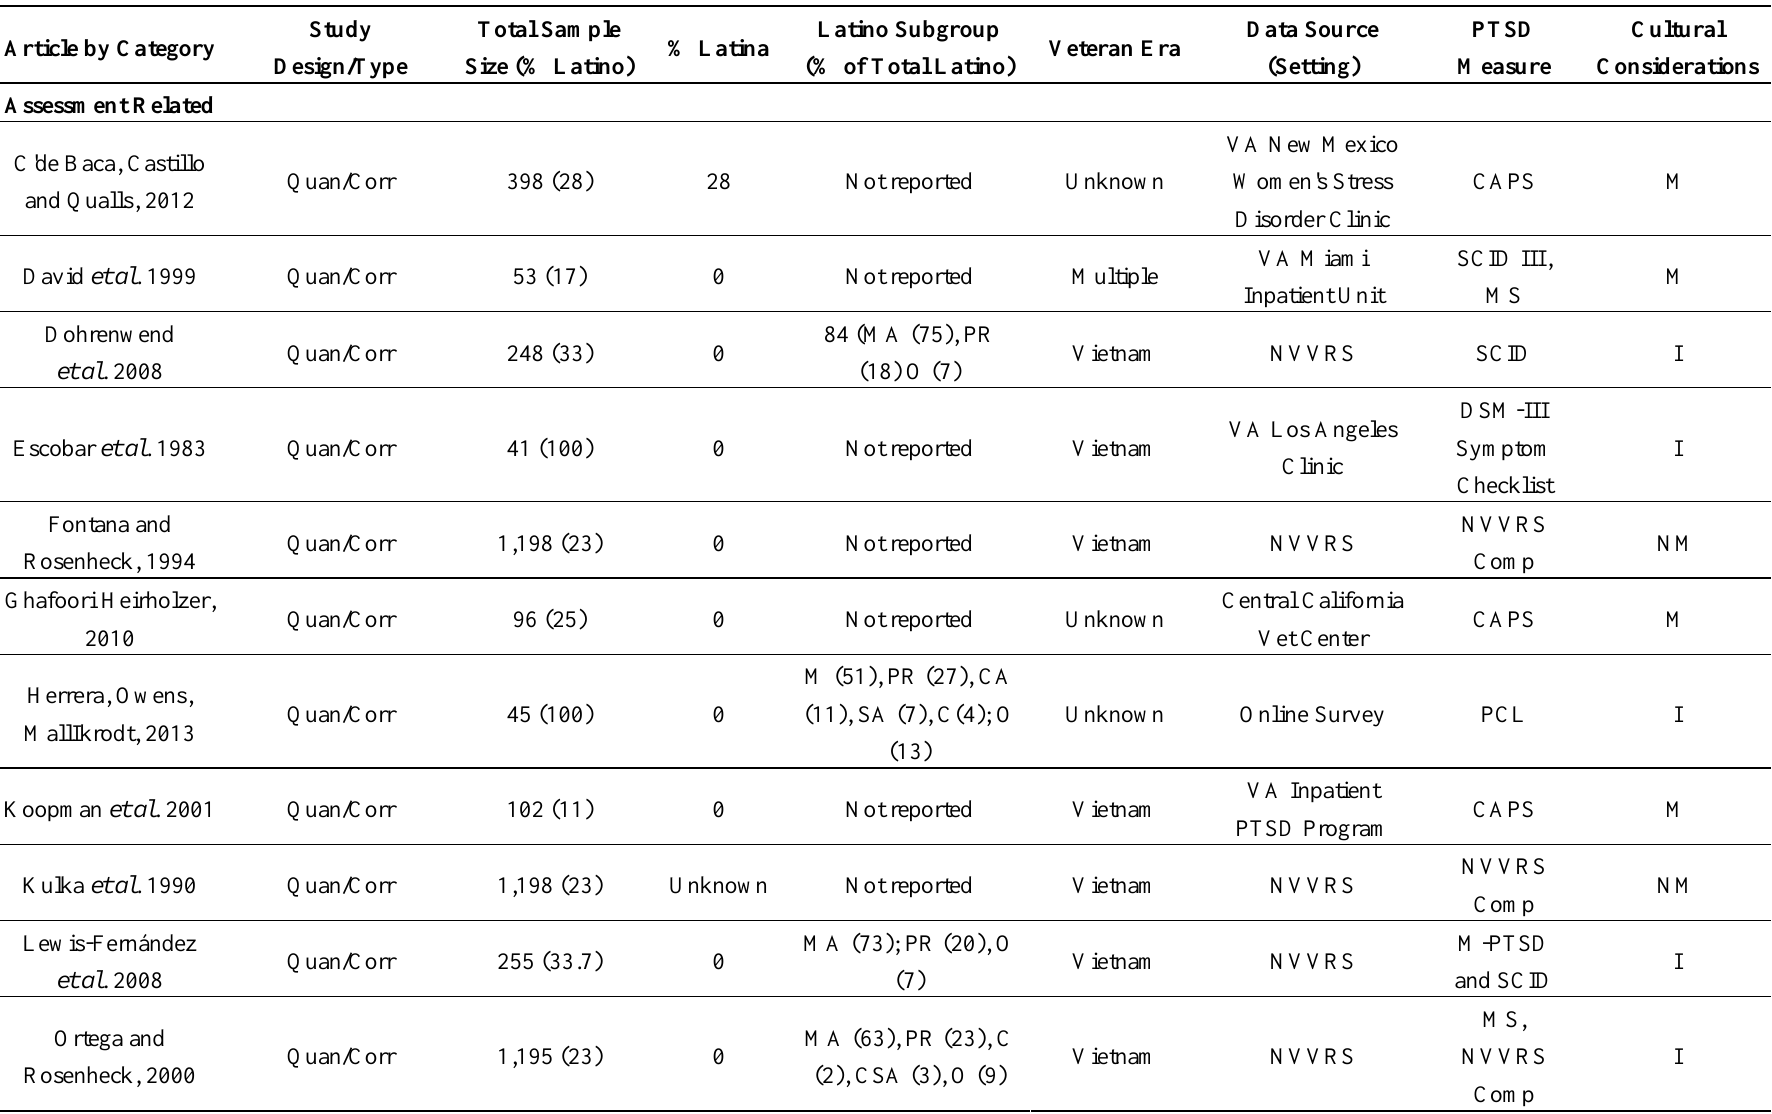
Table 1. Characteristics of the 29 articles on Latino veterans with